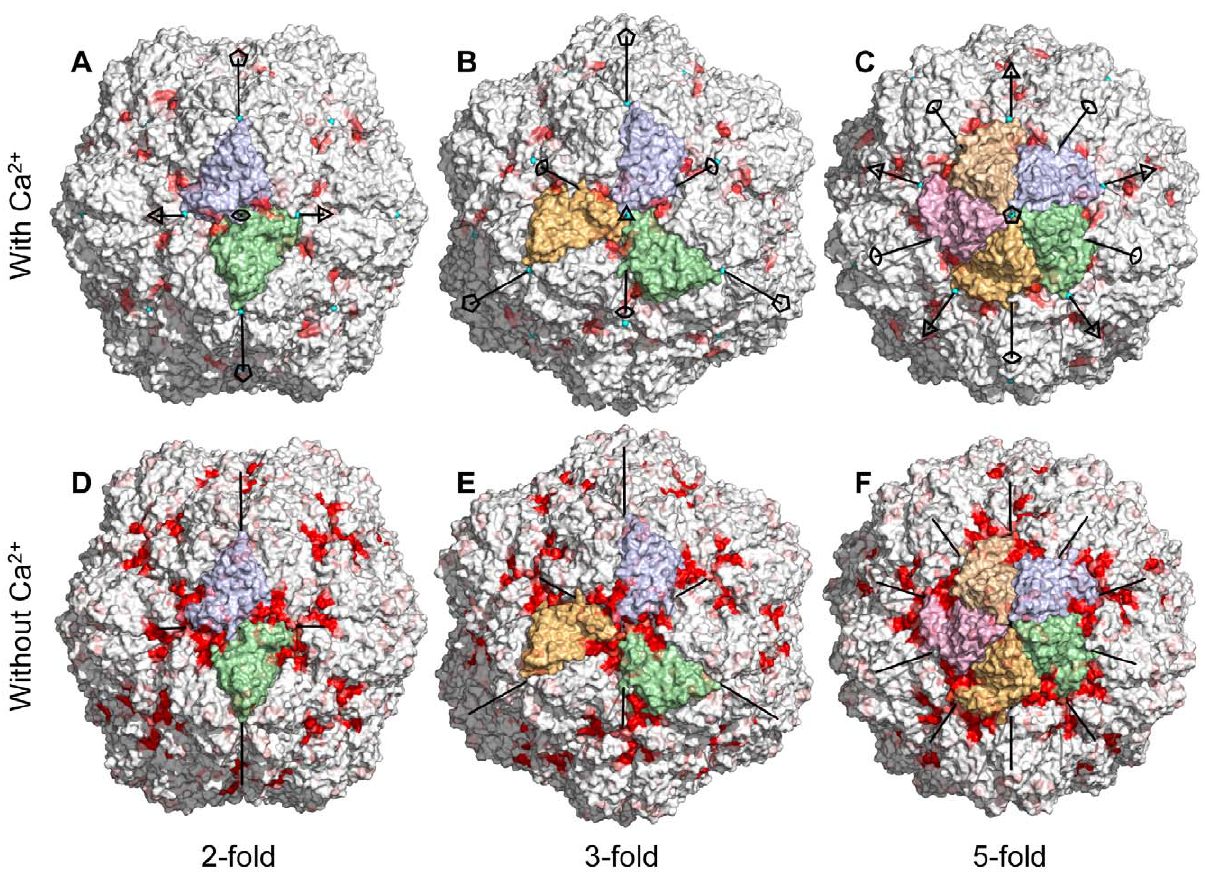
Figure 6. Water permeability mapped on the capsid surface. Van der Waals surface of the capsid after 1 m s simulation. Red color indicates where water molecules pass in or out of the capsid (averaged over the icosahedral symmetry). Top row ( A–C ) with calcium is from Sim Ca D neut (calcium ions shown as cyan spheres). Bottom row ( D–F ) is from Sim NoCa D neut . Views along an icosahedral 2-fold ( A, D ), 3-fold ( B, E ) and 5-fold ( C, F ) symmetry axis respectively. Subunits around the central symmetry axis colored for clarity.